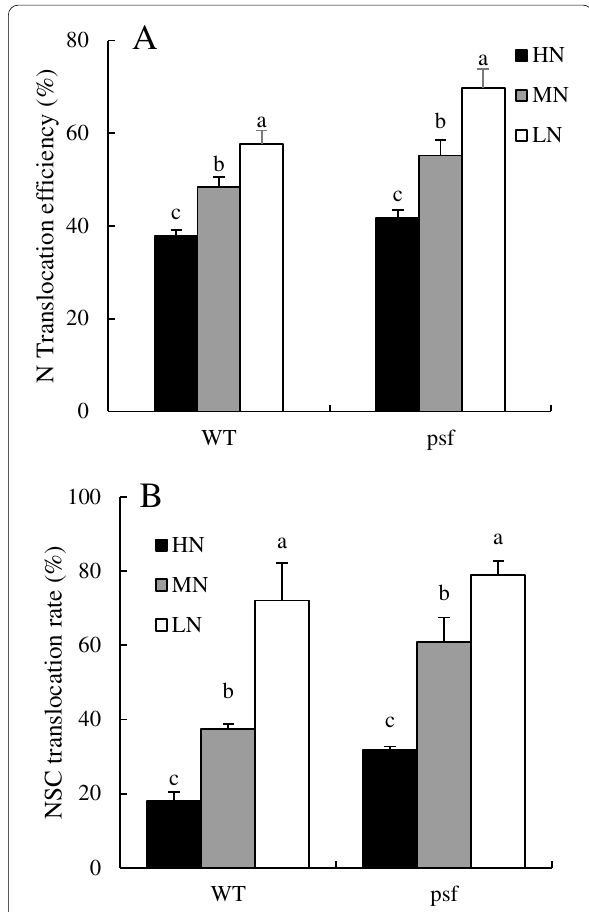
Fig. 3 Carbon and nitrogen translocation rate in the flag leaves of psf mutant and its wildtype under different nitrogen supply. Data are means SD (n 3). Different letters indicate a significant difference ± = between N treatments at p < 0.05 least significant difference (LSD). N translocation efficiency (NTE) (nitrogen translocation/leaf N = content at anthesis) 100. NSC translocation rate [NSCs in leaf at × = the heading stage NSCs residue of the leaf at the harvest stage]/ − NSCs in leaf at the heading